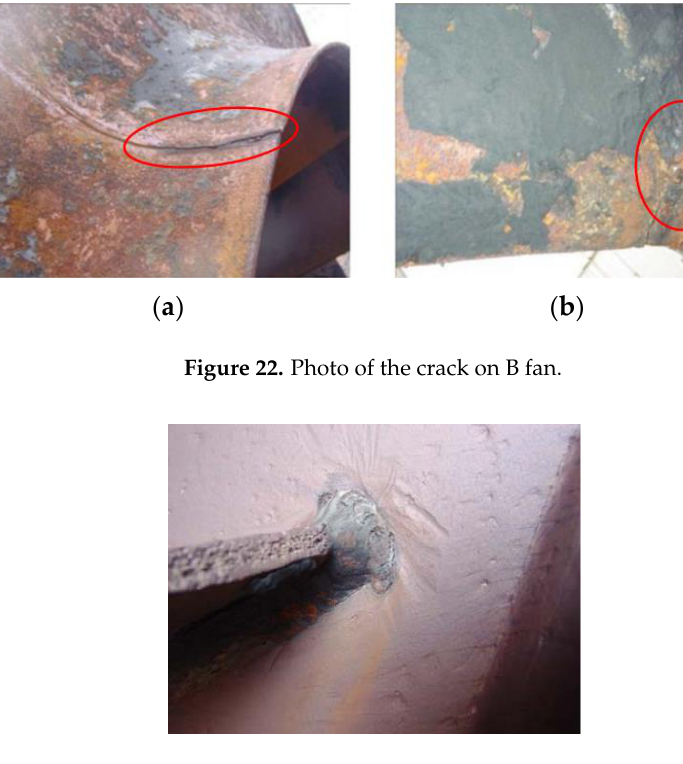
Figure 23. Photo of C fan after repair welding.